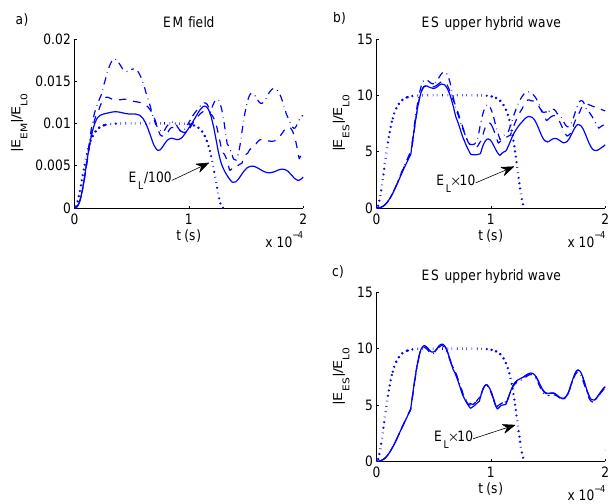
Figure 6. The time development of the amplitudes of the electro- magnetic field (panel a ) associated with Z -mode waves and elec- trostatic field (panel b ) associated with trapped UH waves, for 1, 7 and 19 deep striations (solid, dashed and dash-dotted lines, respec- tively) with α = 0 . 1. The amplitude of the external wave electric field e E L is indicated with dotted lines. The results of purely elec- trostatic simulations are shown in panel (c)